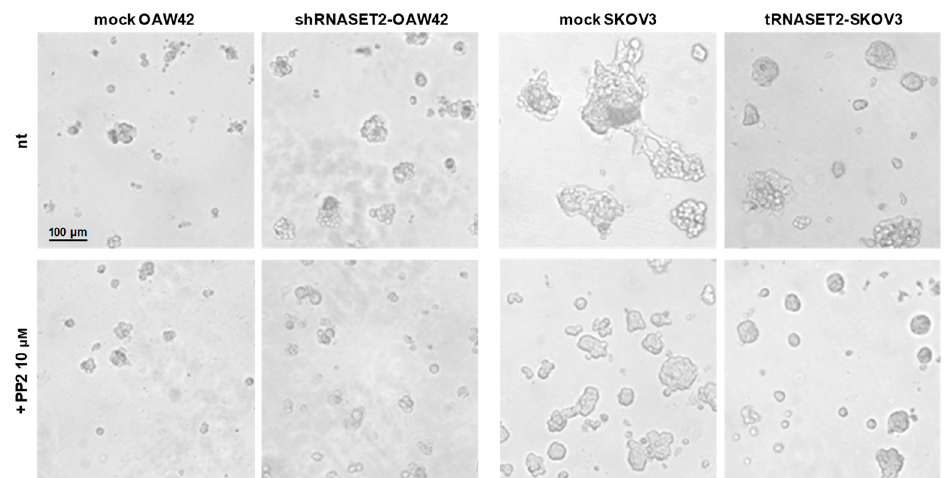
Figure 5. Src inhibitor restores ‘RNASET2 phenotype’. Representative phase contrast images of mock- or shRNASET2-OAW42 (left panel) and mock- or tRNASET2-SKOV3 cells (right panel) growing and invading Matrigel ® up to 7 days with or without PP2 (10 μ M).